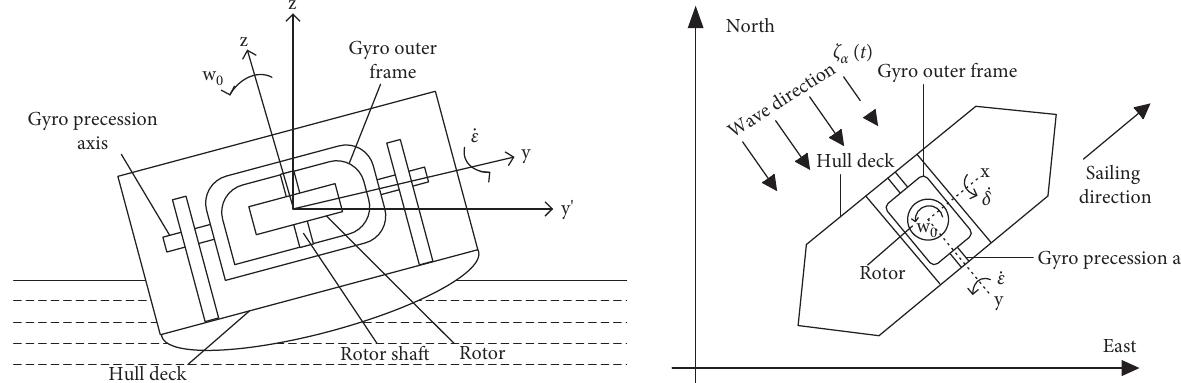
Figure 1: The coordinate system of dynamic